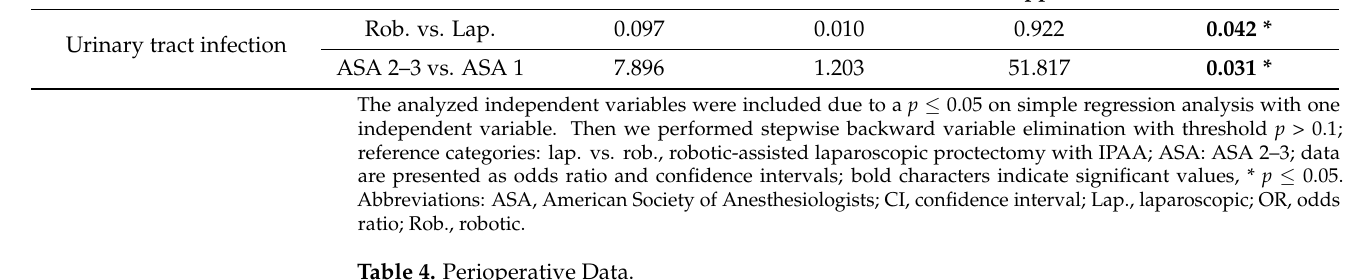
Table 4. Perioperative Data.